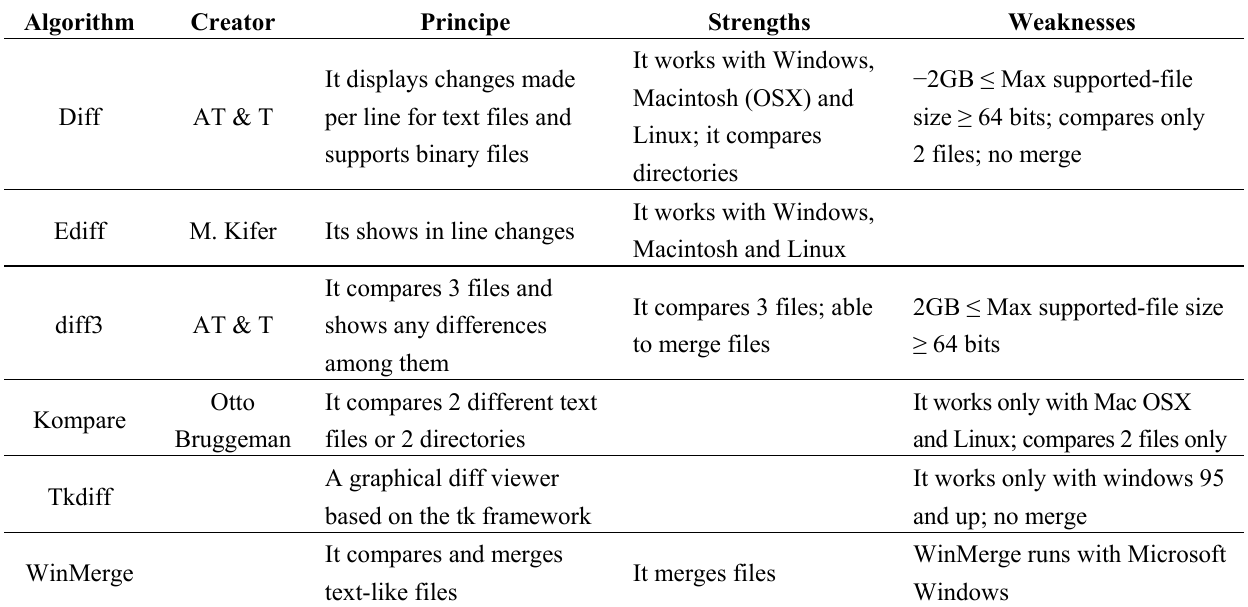
Table 6. Comparative table of free diff algorithms [24].